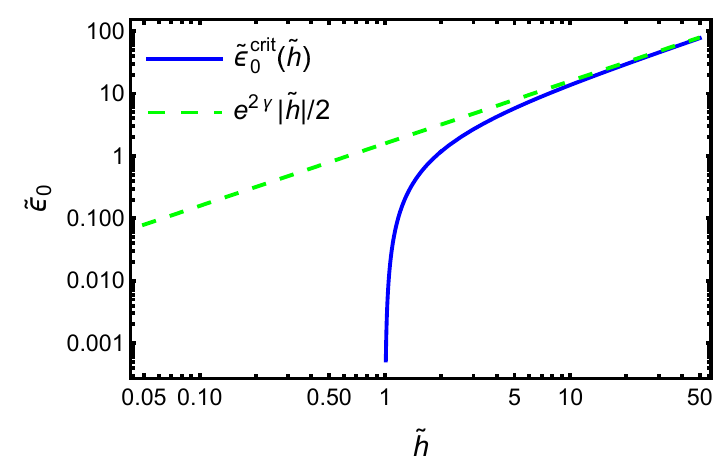
-˜ h space with a two-fermion bound state. Figure 2: Boundary of the region in ˜ ε 0 The solid blue curve plots Eq. (51) for the dimensionless critical interaction strength ( ˜ h ) above which a bound state exists in the presence of spin-orbit coupling. Its ˜ ε crit 0 asymptote e 2 γ | ˜ h | / 2 for large dimensionless Zeeman coupling ˜ h ≡ h / ( m λ 2 ) is indi- cated by the dashed green line. For pairs of parameter values ( ε , h ) from the region 0 above this line, bound states are formed also in the absence of spin-orbit coupling. In contrast, in the region between the two curves, s -wave-attraction-generated bound states would not exist without spin-orbit